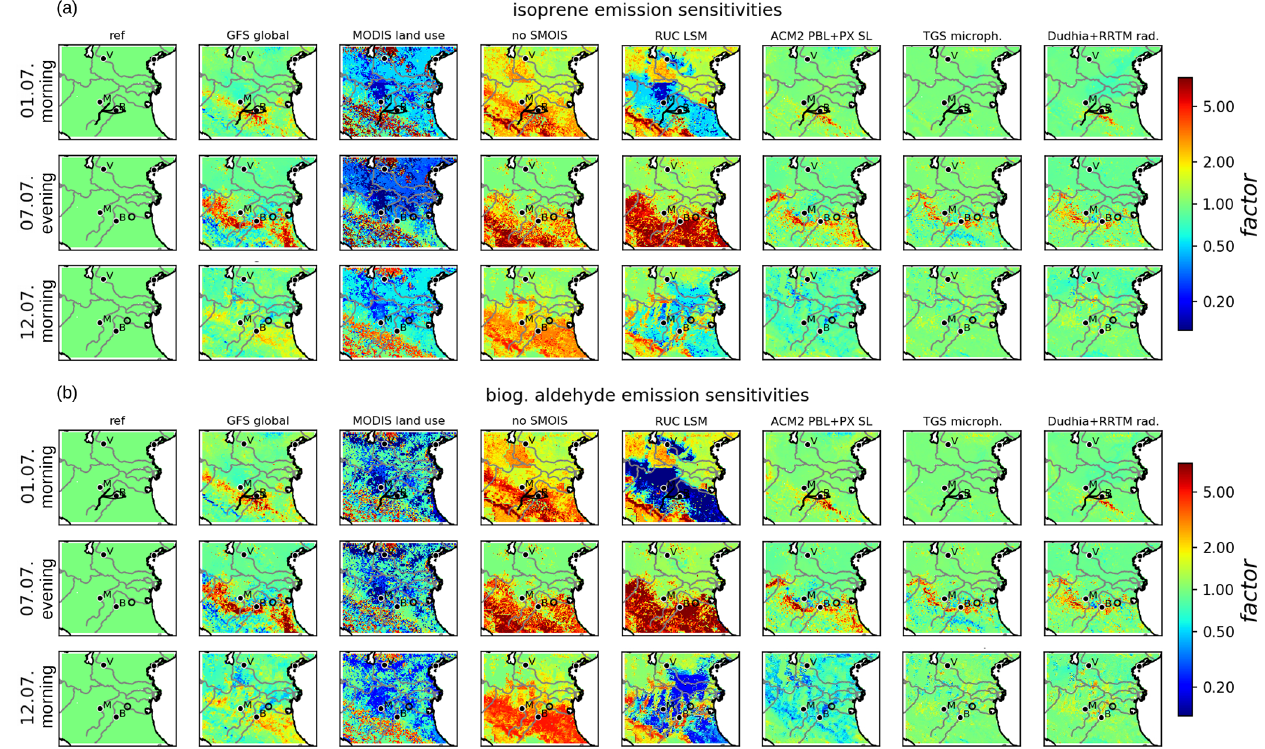
Figure 9. Averaged sensitivities to isoprene (a) and biogenic aldehyde (b) emissions on 1 July morning (00:00–10:00UTC), 7 July evening (12:00–22:00UTC) and 12 July morning (00:00–10:00UTC) (temporally averaged factors with respect to reference; coded by color) for different model configurations. Plotting conventions are like in Fig.